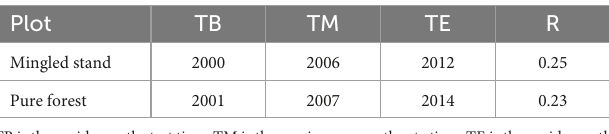
TABLE 3 Growth rate results of the two sample plots.